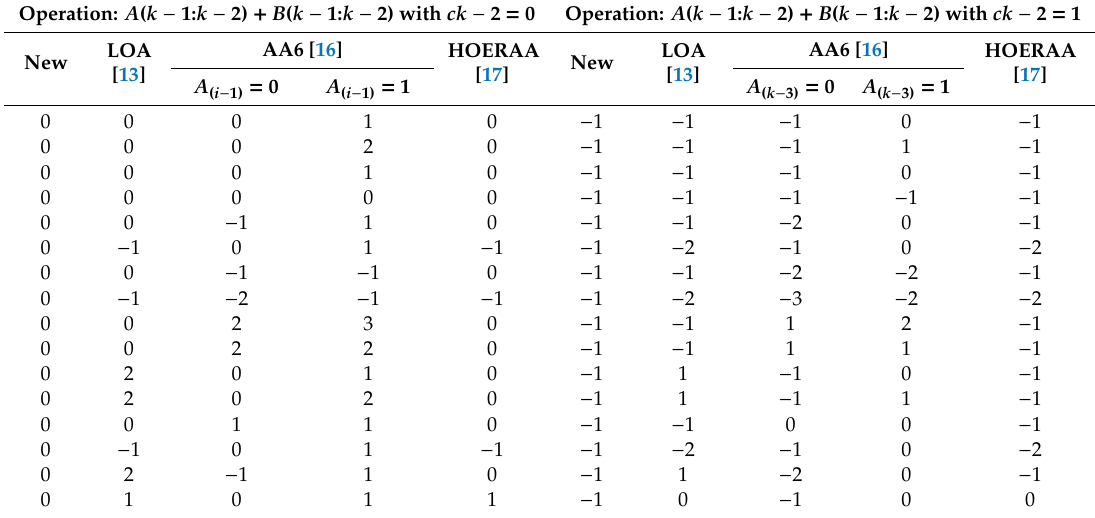
Table 5. Errors introduced on the 2 MSBs of the inexact